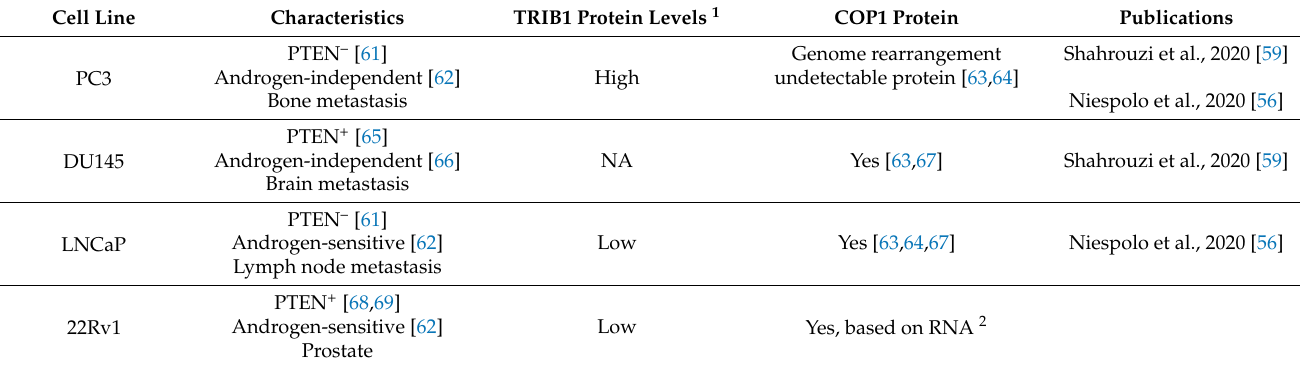
Table 1. Characteristics of prostate cancer cell lines used by TRAIN